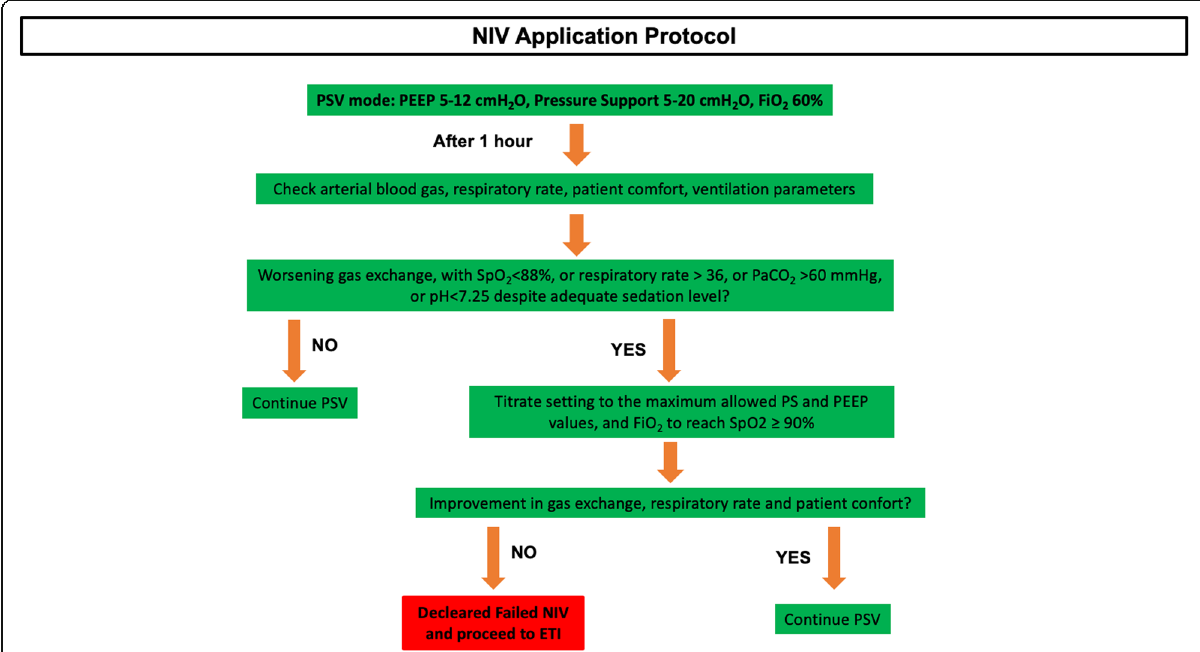
Fig. 1 NIV protocol. The figure shows the NIV protocol adopted for the patients admitted to ICU. When patients started with CPAP mode at ICU admission, we set a PEEP value ranging between 5 and 12 cmH 2 O and FiO 2 60%. After 1 h, the clinician evaluated gas exchanges, by arterial blood gas analysis, respiratory rate, and patient ’ s comfort. In case of worsening gas exchange with SpO 2 < 88%, or respiratory rate > 36, or PaCO 2 > 60 mmHg, or pH < 7.25 despite adequate sedation level, the patient stopped CPAP and started NIV in PSV mode according to our protocol. On the contrary case, the patient continued CPAP mode